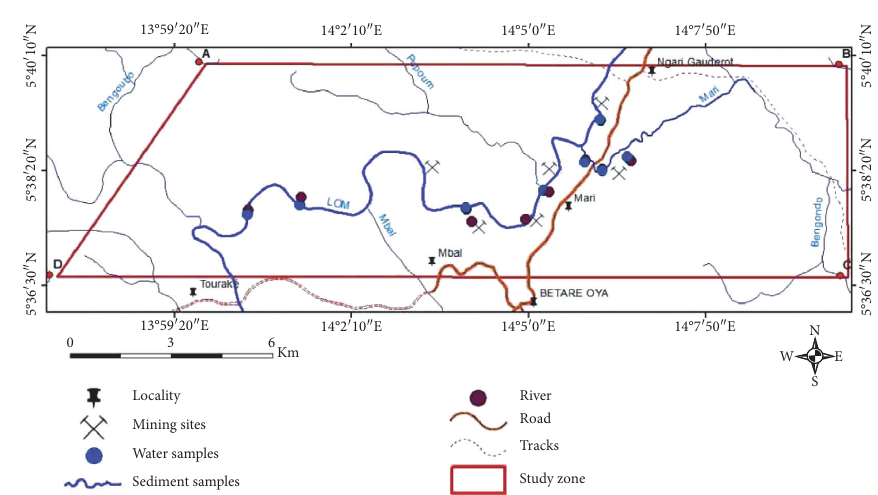
Figure 1: Location map of the study area.